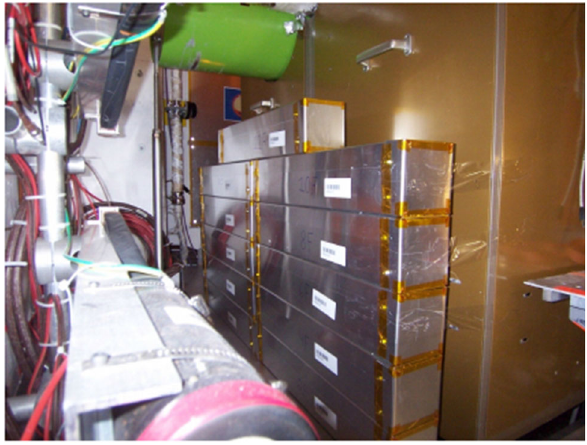
Fig. 5 A photograph of the prototype MMT detector deployed at IP8